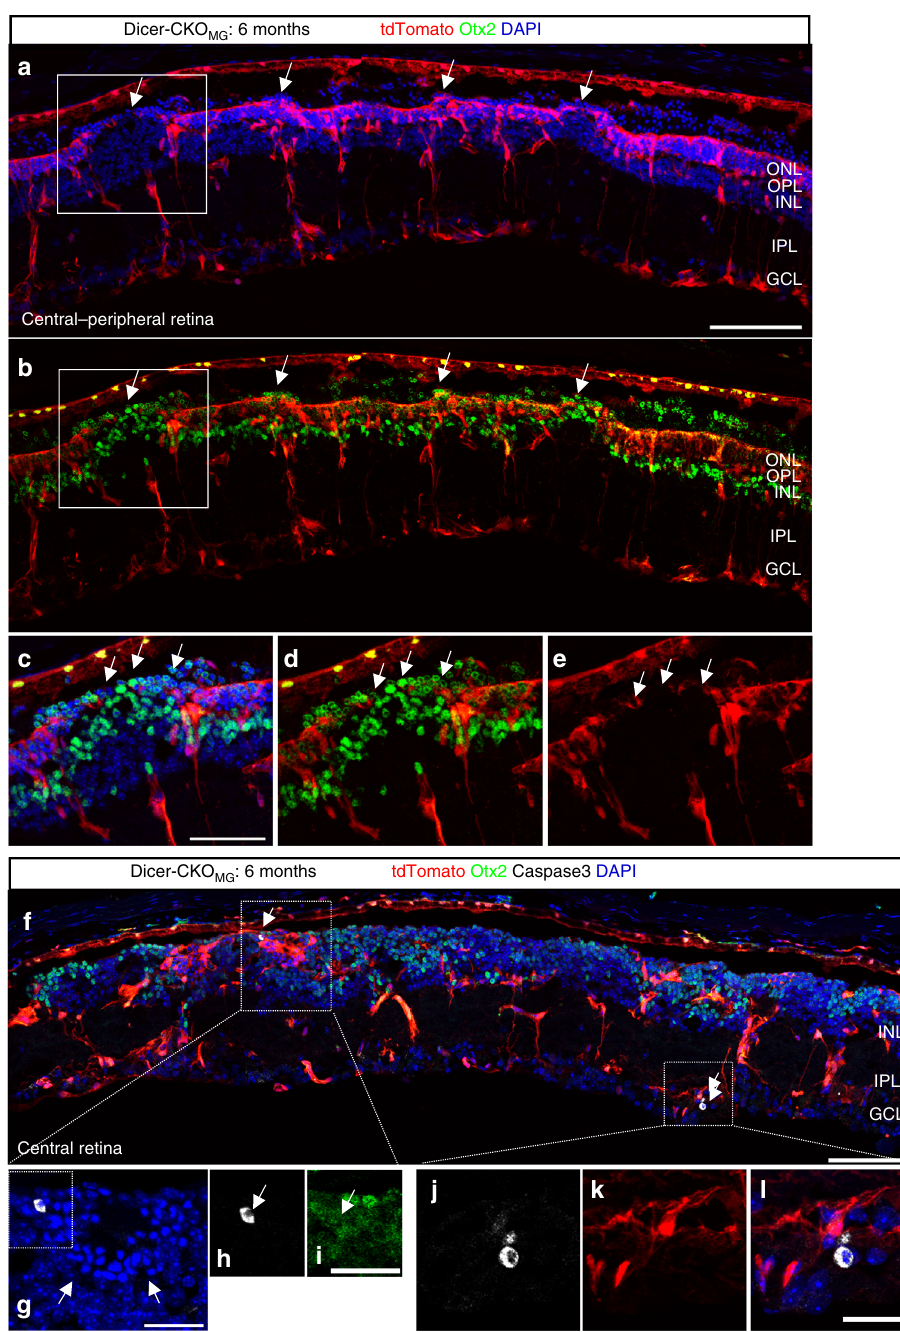
Fig. 2 Retinal organization is disrupted 6 months after Dicer1 deletion. Immuno fl uorescence for tdTomato (endogenous, unlabeled), Otx2, Caspase3, and DAPI of retinal cross sections of an adult Dicer-CKO MG mouse, 6 months after Dicer1 deletion that received Tamoxifen at postnatal day (P) 11 – 14. Arrows in a – e show regions were the outer limiting membrane (OLM) is disrupted. Arrows in f show Caspase3 + cells, found in the INL, in rosette like formations ( g - i ), or in the GCL ( j - k ). Mice of at least two different litters were analyzed. Scale bars in a , f : 100 µ m, in c : 50 µ m, in g , i , l : 25 µ m. ONL, OPL, INL, IPL, GCL, as de fi ned in Fig. 1